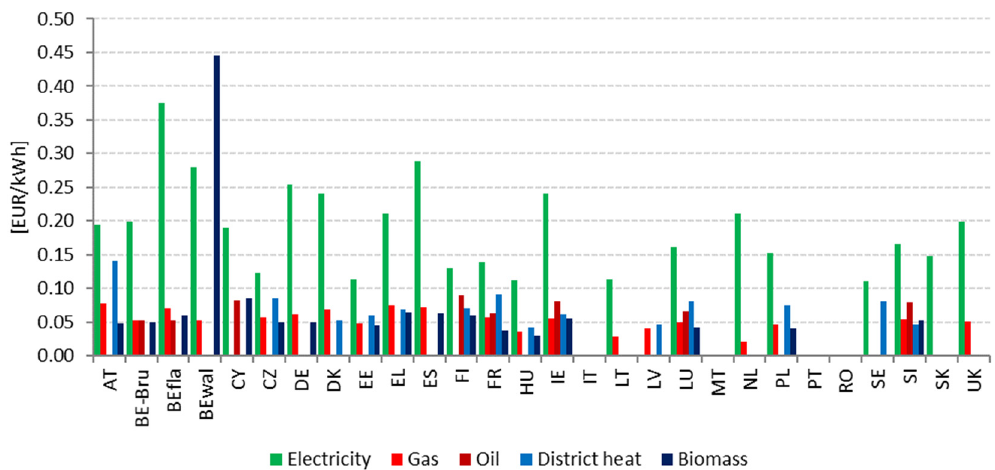
Figure 5. Energy prices used by Member States for residential sector. Table 2. Statistics about the energy prices selected for residential (Res) and non-residential (N-Res) buildings.